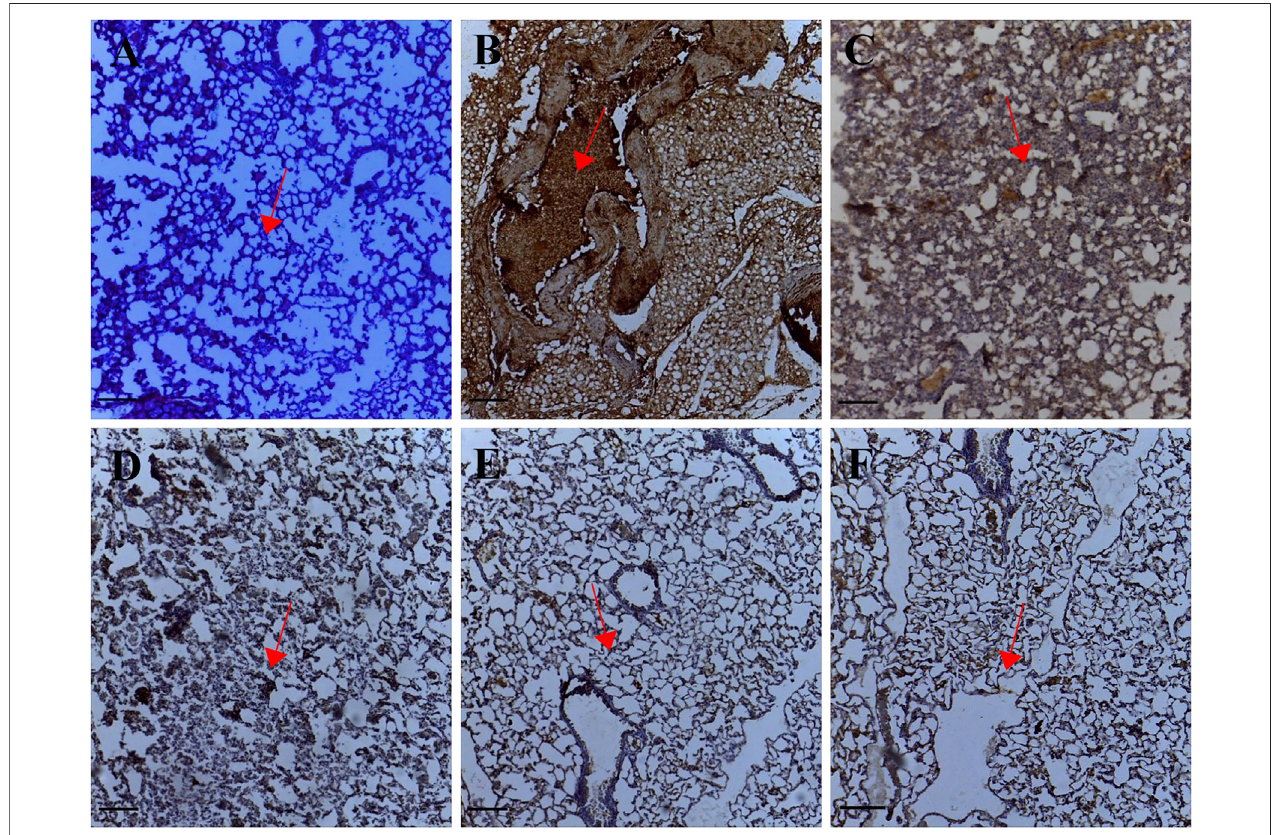
FIGURE 3 | Representative photomicrographs of MTA1 expression in IHC sections of the lung tissue: (A) Normal saline (B) Lung metastasis (C – E) Palmatine 1 – 10 mg/kg (F) Doxorubicin5 mg/kg.Datawereobtainedfrom fi ve fi eldsperslidewithsevenslidesanalyzedfromeachgroup.Redarrowsshowimmunoreactiveareas. Scale bar 20 mm (×10, (A – F)